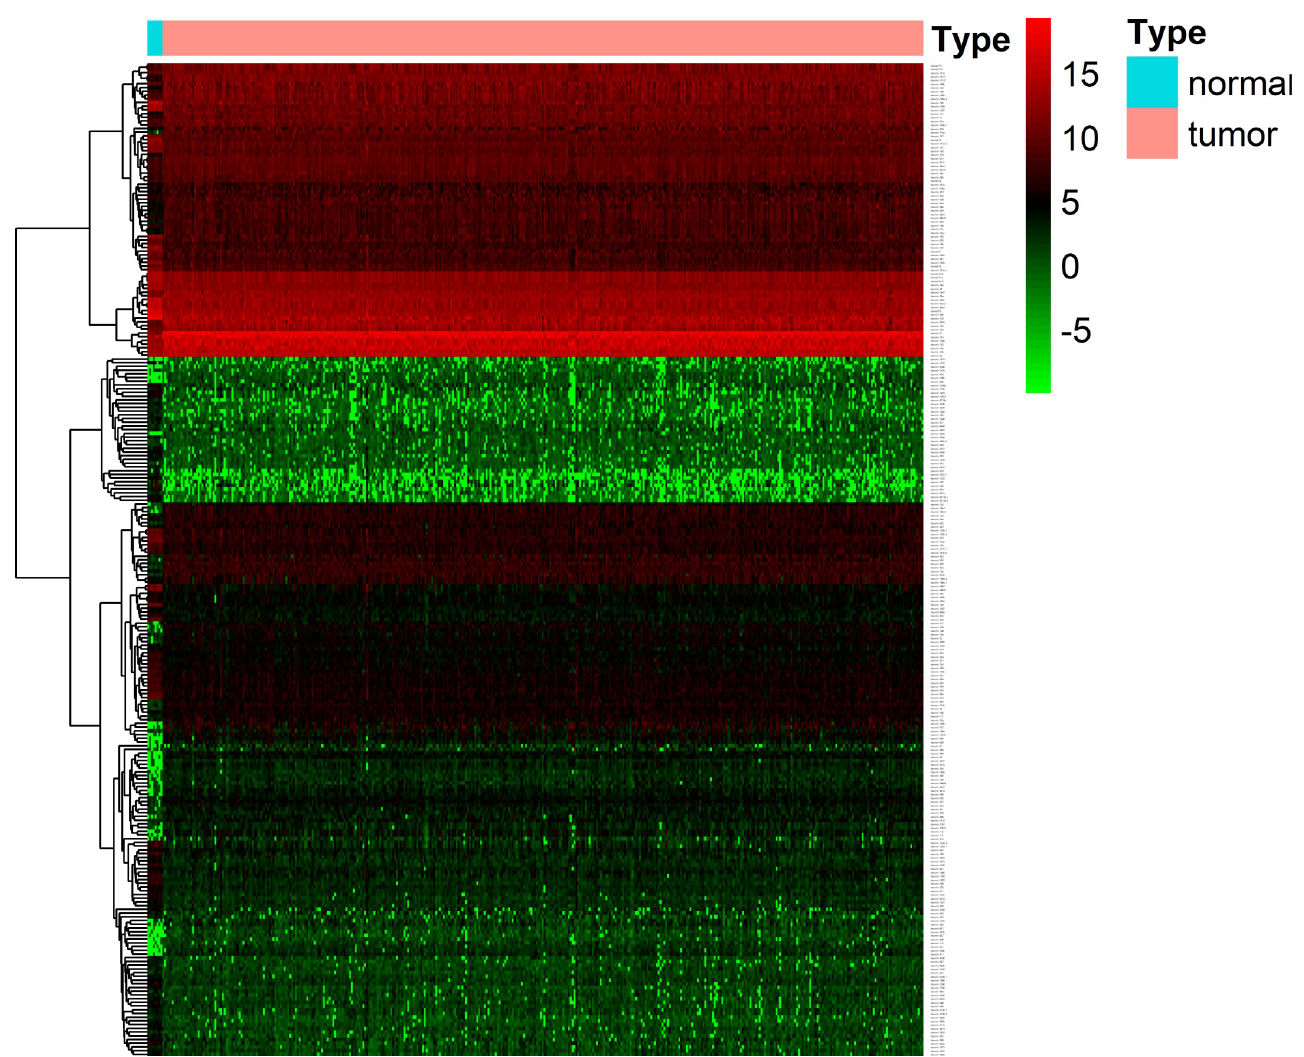
Fig 1. Heatmap of miRNA expression in CC. The horizontal axis above indicates the groups of samples. The vertical axis on the left shows the cluster of different miRNAs, and the right axis shows the miRNA name. Red indicates high expression, and green indicates low expression. miRNA, microRNA; CC, colon